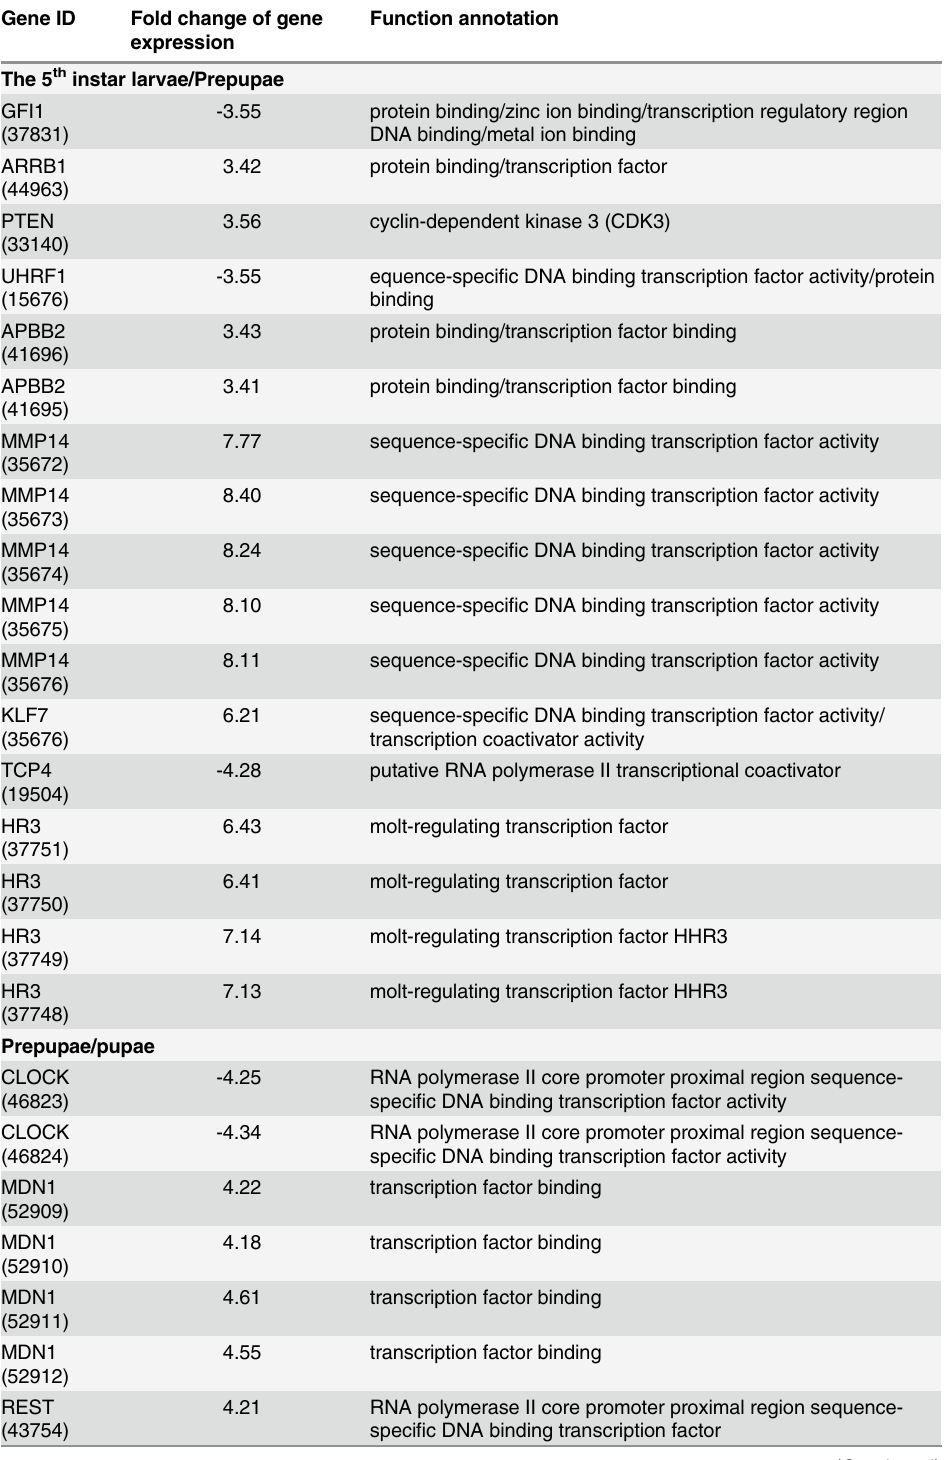
Table 5. Expression abundance of most differentially expressed transcription factors during larval to pupal development. Silk formation is highest in 5th instar larvae, lower in prepupae and does not occur in